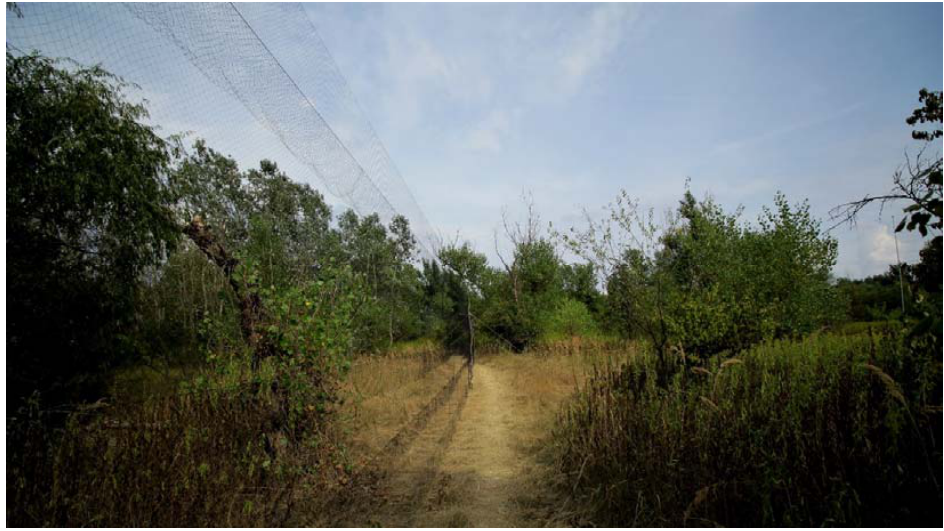
Figure 1. Ornithological net used to catch birds during the study. Photo by R.